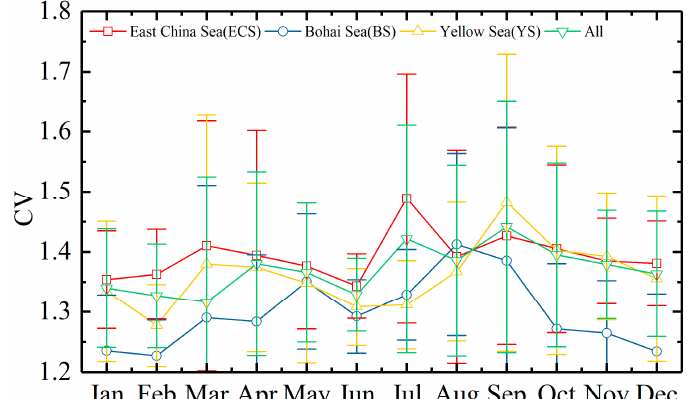
Figure 11. Changes of coefficient of variation (CV) of monthly TSS levels for China’s seas from GOCI observations from 2013 to 2017.